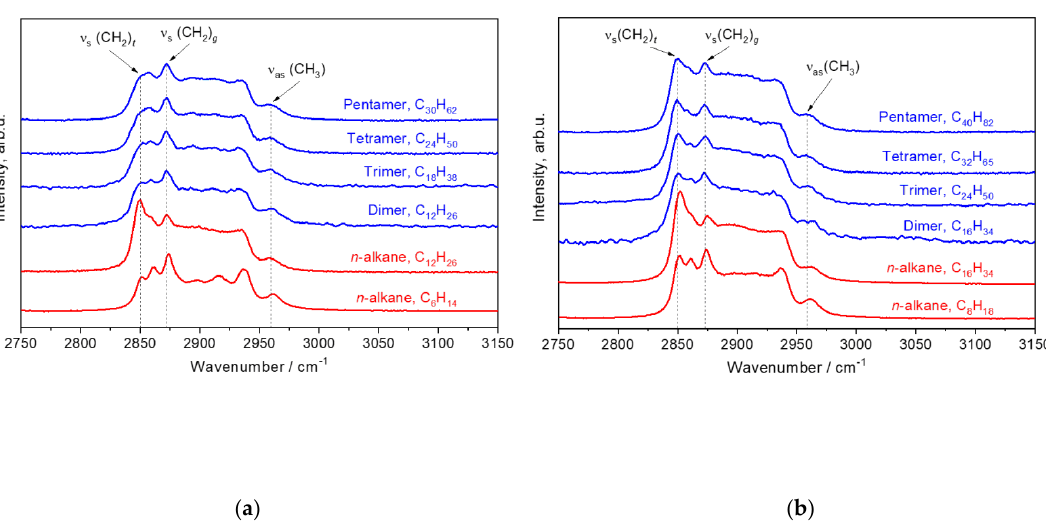
Figure 10. Non-polarized Raman spectra of the hydrogenated 1-hexene ( a ) and 1-octene ( b ) oligomers and linear alkanes C 6 H 14 , C 8 H 18 , C 12 H 26 , and C 16 H 34 in the region 2750–3150 cm − 1 .